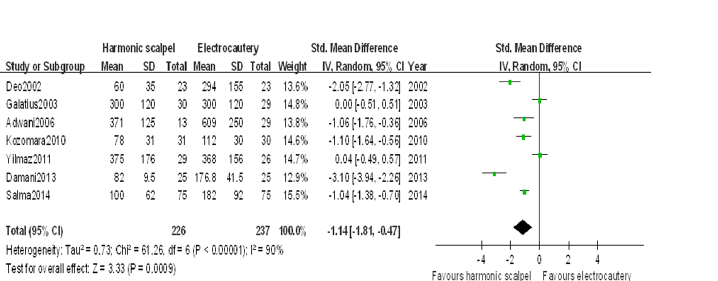
Fig 3. Forest plot for odds ratio of seroma development between harmonic scalpel dissection and electrocautery in mastectomy used by fixed-effect model.